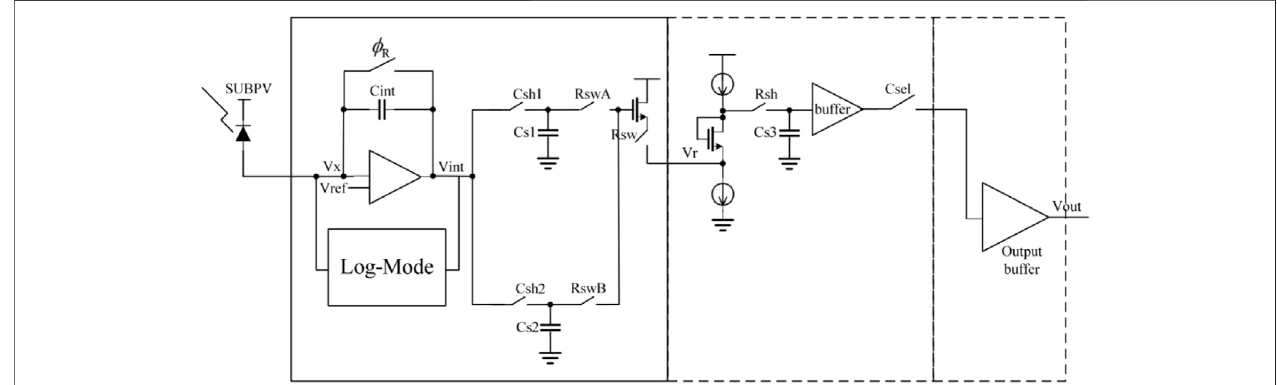
FIGURE 4 | The circuit of